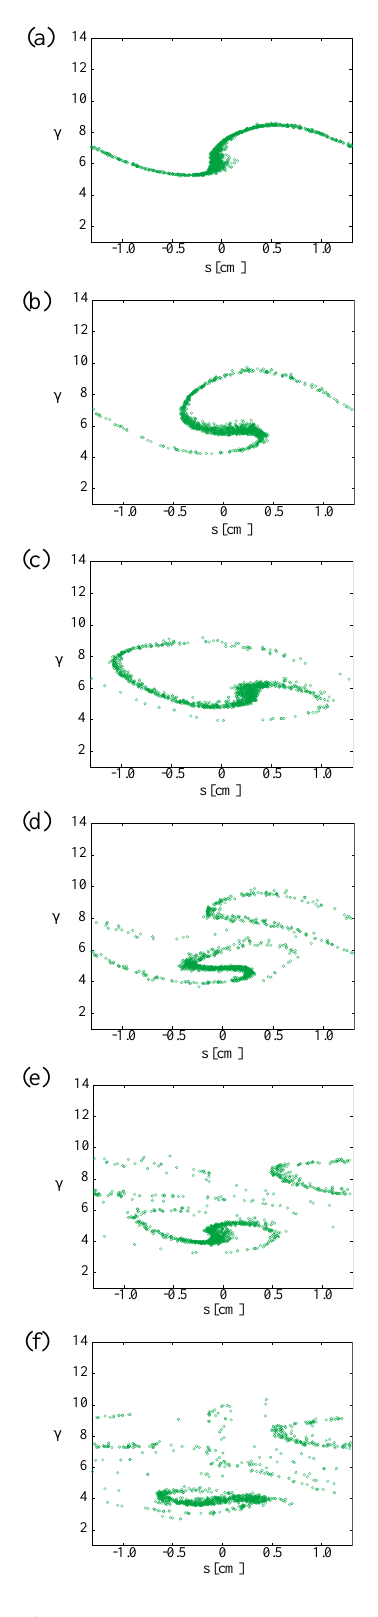
FIG. 20. (Color) Longitudinal phase-space evolution in after- burner operation, taken from the exit plane of cavities #15 (a), #20 (b), #25 (c), #30 (d), #35 (e), #40